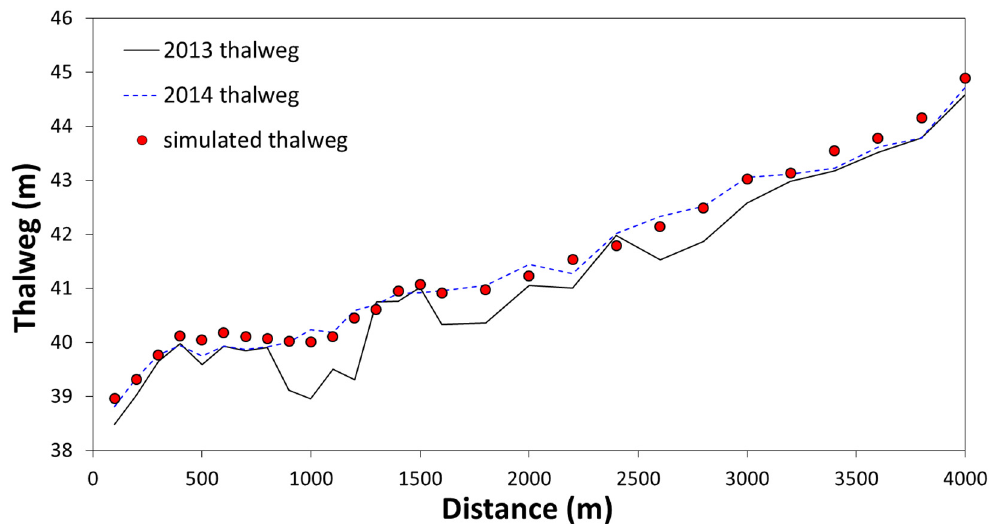
Figure 7. Topographic and elevation map of the study area: ( A ) distributions of bed elevation, ( B ) mesh of the study area.